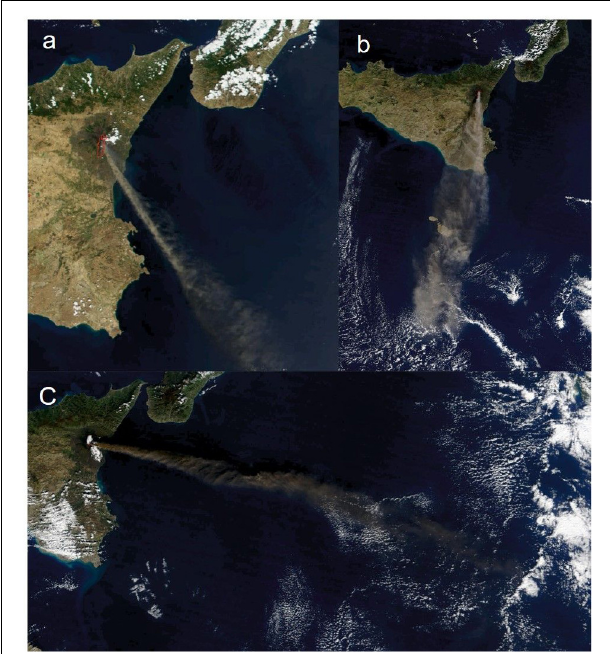
FIGURE 1 | Satellite images of ash dispersal during the 2001 and 2002–2003 Mount Etna eruptions. (a) July 22, 2001; Image courtesy Jacques Descloitres, MODIS Land Rapid Response Team at https://visibleearth.nasa.gov/ view.php?id=56431. (b) October 27, 2002; image courtesy Jacques Descloitres, MODIS Rapid Response Team at NASA GSFC, at https://visibleearth.nasa.gov/view.php?id=10376. (c) November 12, 2002; image courtesy Jeff Schmaltz, MODIS Rapid Response Team, NASA GSFC at https://visibleearth.nasa.gov/view.php?id=10398. Mount Etna coordinates 37 ◦ 45 (cid:48) 18 (cid:48) N, 14 ◦ 59 (cid:48) 42 (cid:48)